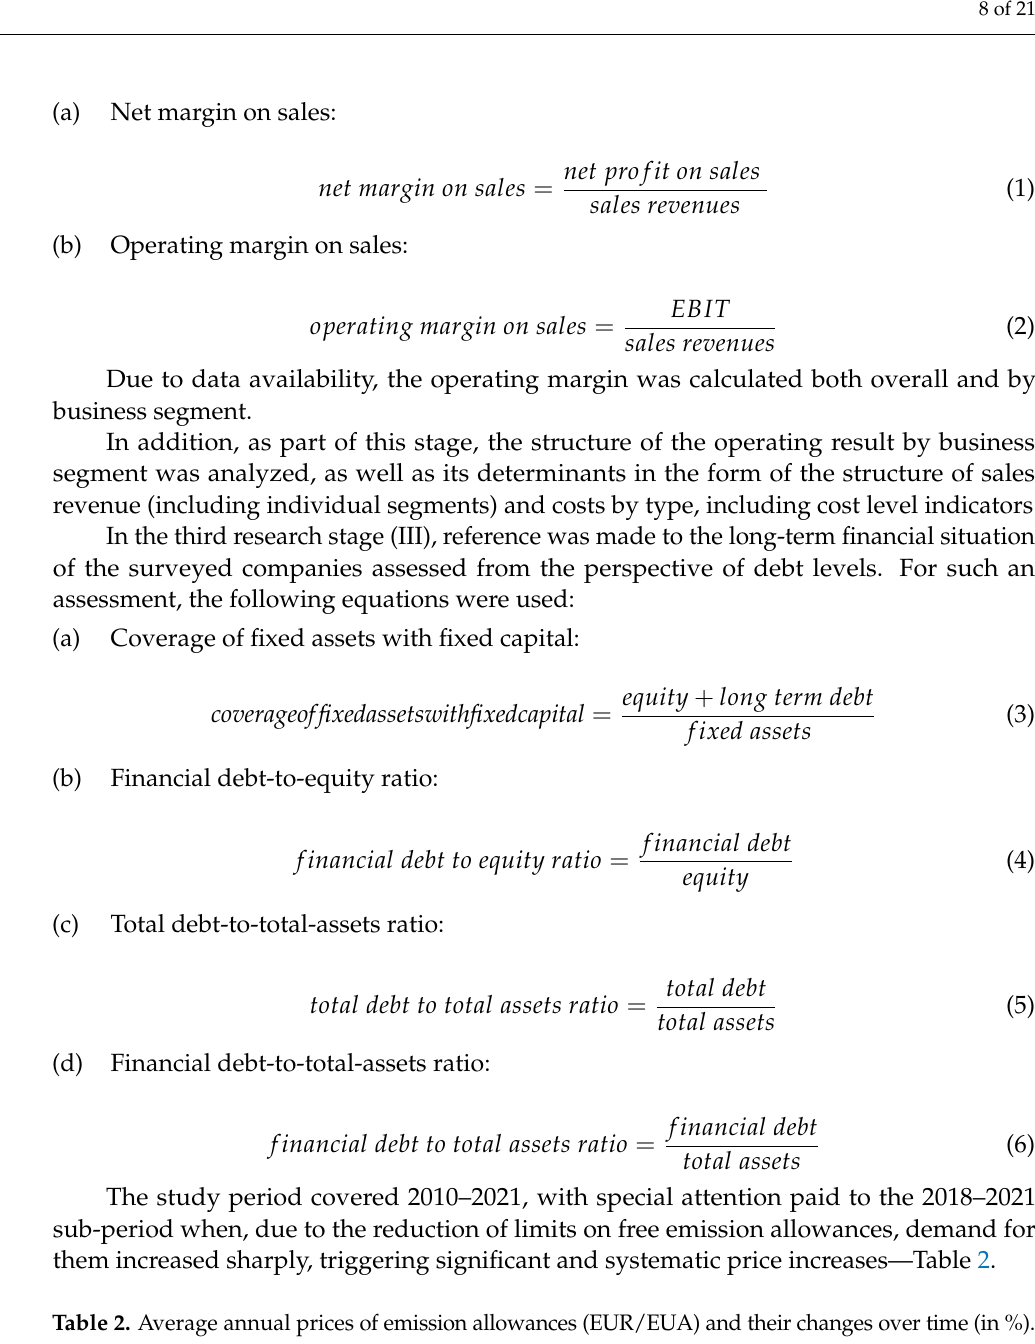
Table 2. Average annual prices of emission allowances (EUR/EUA) and their changes over time (in %).